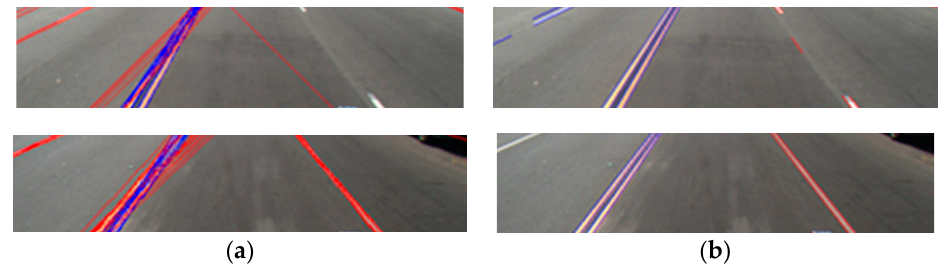
Figure 5. Comparisons of line detection: ( a ) line detection using conventional edge detector and Hough transformation (HT); and ( b ) line extraction using line segment detector (LSD).